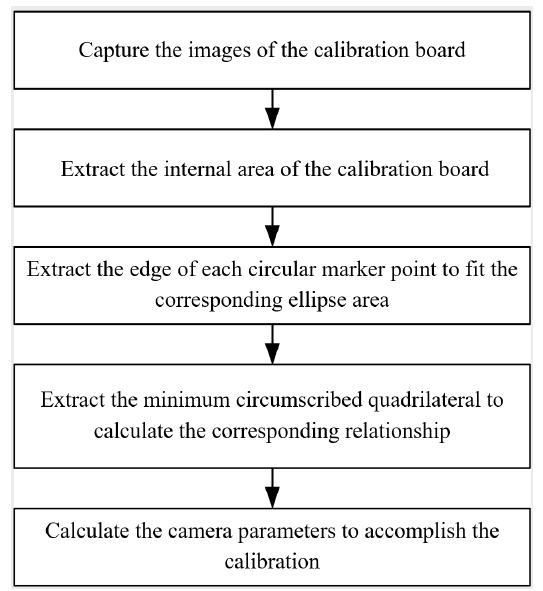
Figure 9. The calibration precedes of the optical imaging system.